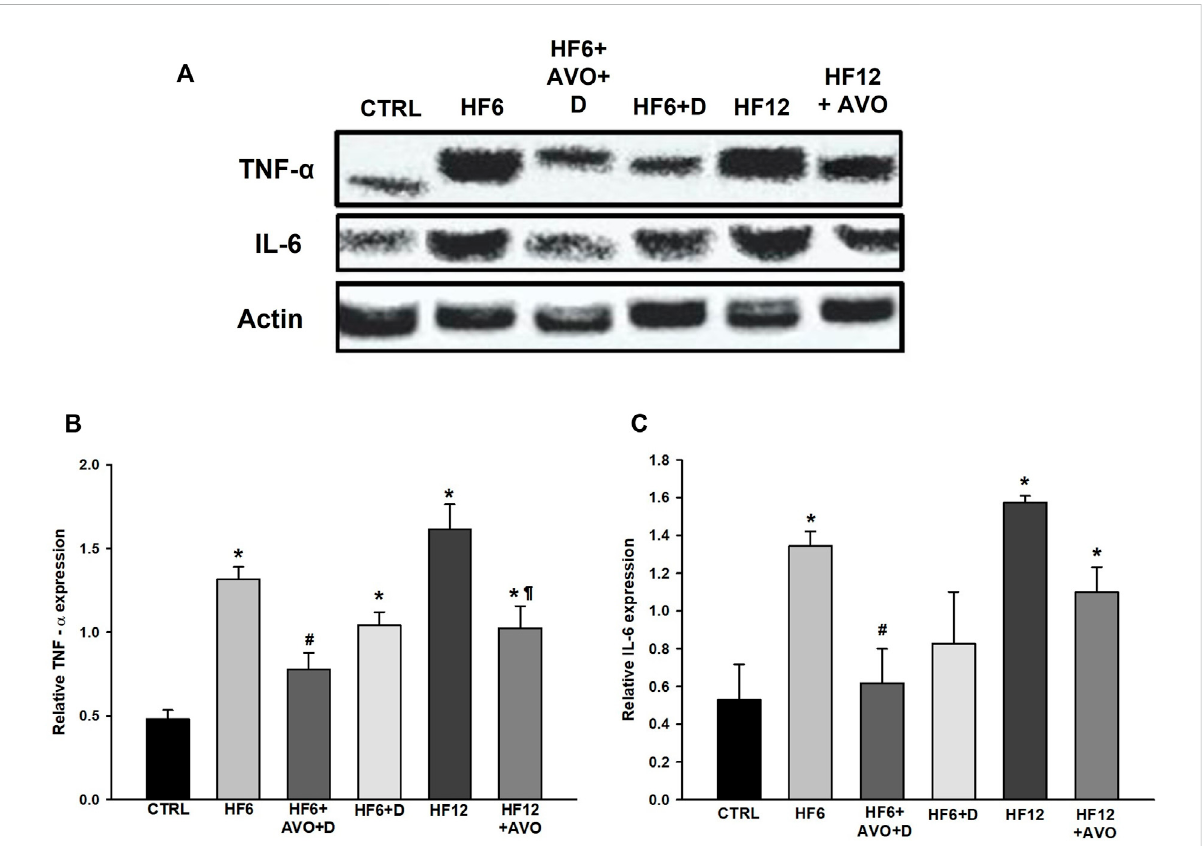
FIGURE 8 Effectsofavocadooilonthelevelsofproin fl ammatorycytokinesinratliver. (A) Representativeblotsshowingthelevelsoftumornecrosisfactor alpha (TNF- α ) and interleukin-6 (IL-6). Quantitative analysis of TNF- α (B) and IL-6 (C) levels. Data are expressed as the mean ± standard error of n ≥ 3.* p < 0.05 vs. CTRL; # p < 0.05 vs. HF6; § p < 0.05 vs. HF6+AVO + D; p < 0.05 vs. HF12 (ANOVA, Holm- Š ídák ’ s post hoc